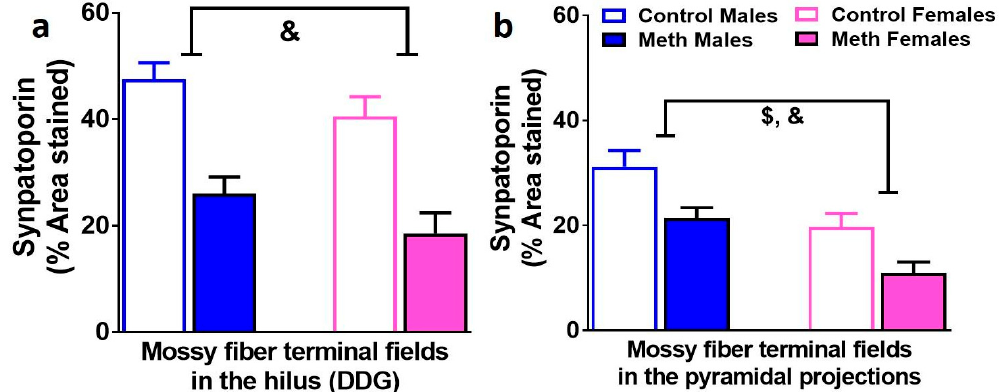
Figure 5. Mossy fiber tracts in the DG are distinctly altered in males and females. ( a , b ) Quantitative analysis of the density measures in the hilus ( a ) and CA3 pyramidal projections ( b ). Data shown are represented as the mean ± SEM. n = 12–19 males, n = 8–13 females. &, main effect of reinstatement; $, main effect of sex by two-way ANOVA.